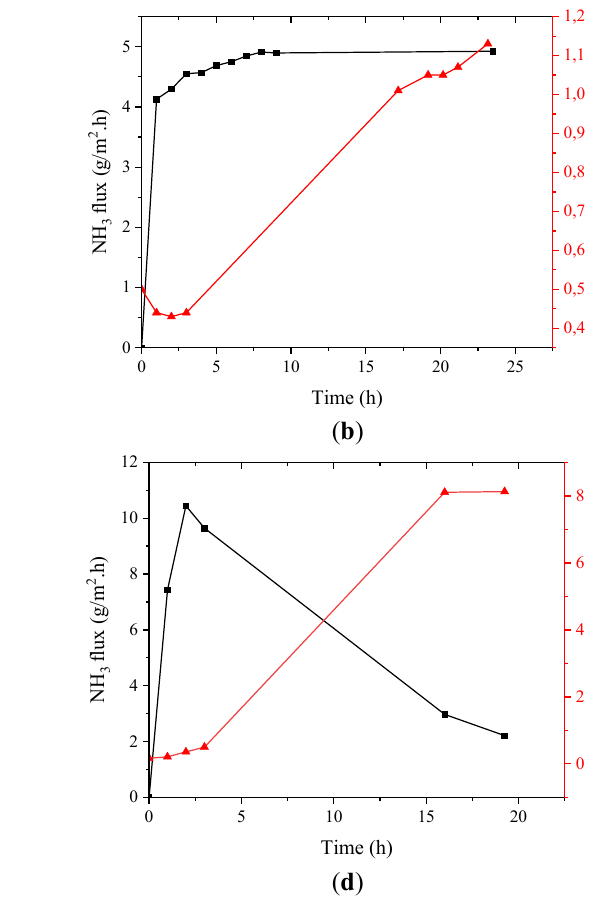
Figure 3. Ammonia flux and acid pH of ( a ) M1, ( b ) M2, ( c ) M3, and ( d ) M4.